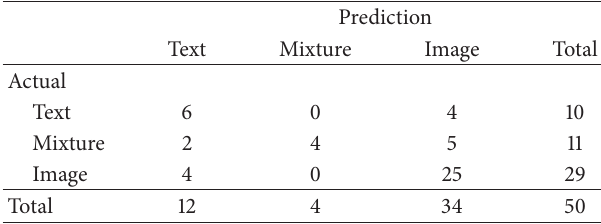
Table 1: Confusion matrix for the classification